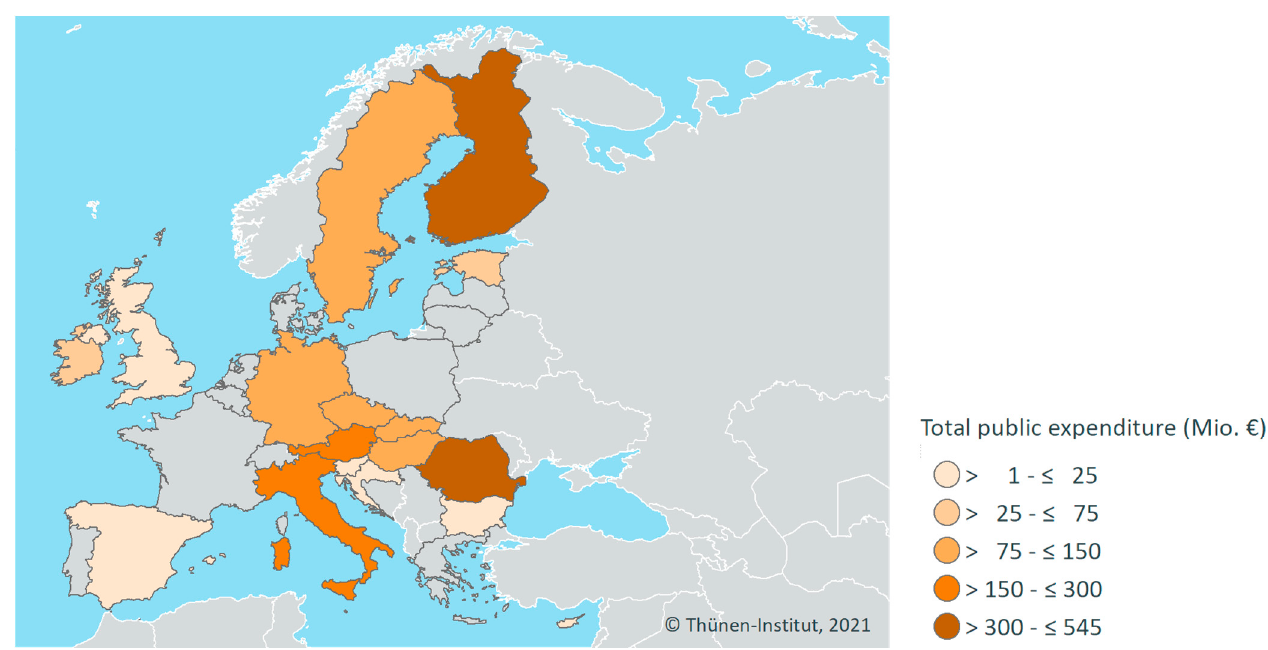
Figure A1. Total public expenditure for Measure M14—Animal Welfare in the EU Member states in 2014–2019; Source: https://cohesiondata.ec.europa.eu/ (accessed on 19 January 2021). Data and Maps, esri (2021).